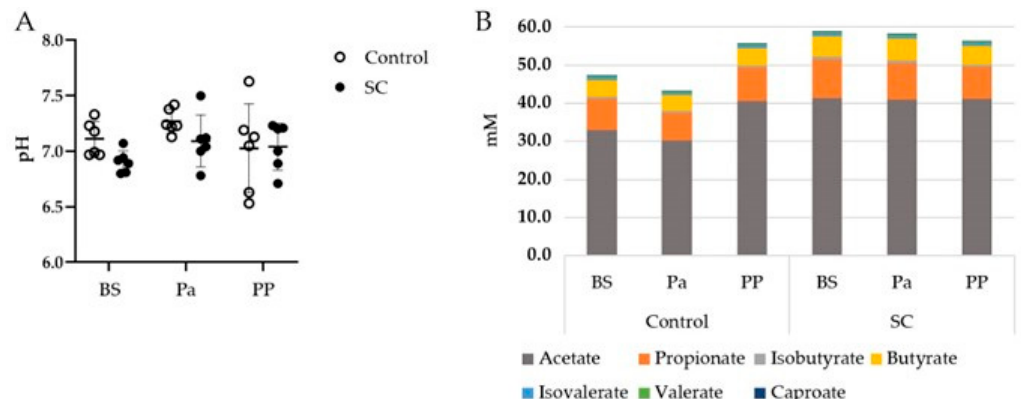
Figure 1. ( A ) Evolution of the rumen pH, ( B ) Mean VFA concentrations (mM) in the rumen contents of the ewes from the control or SC groups ( n = 6 per group) over the experimental period. BS = before supplementation of SC, Pa = close to parturition, PP = 2 weeks postpartum.